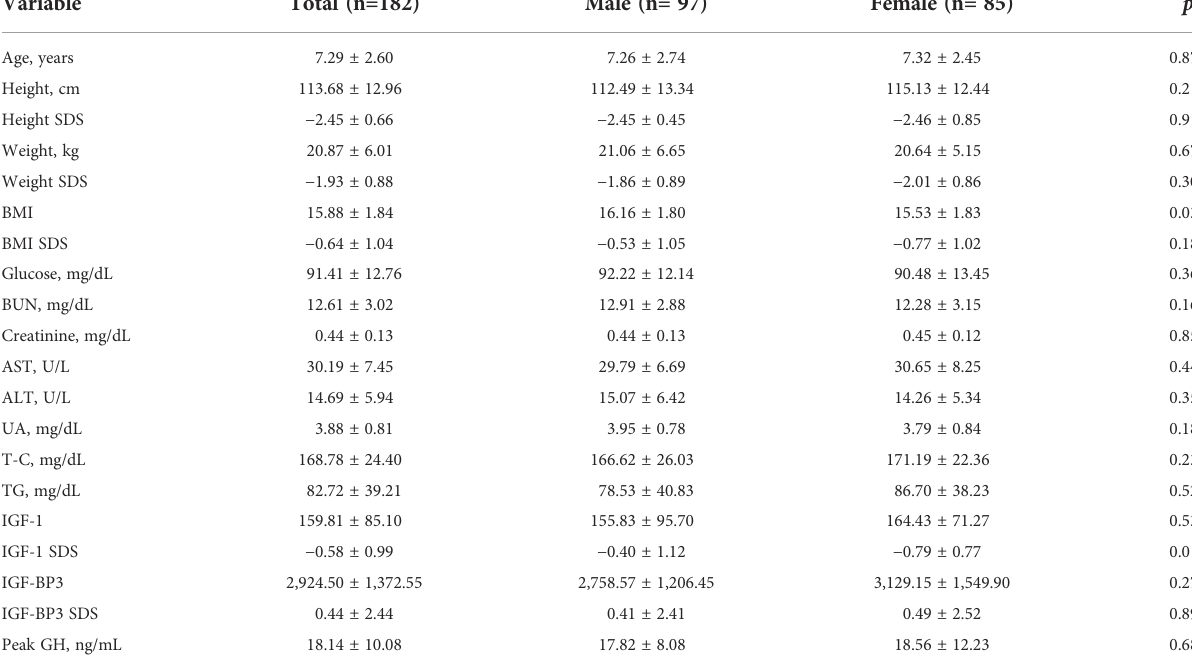
TABLE 1 Baseline clinical characteristics of the study